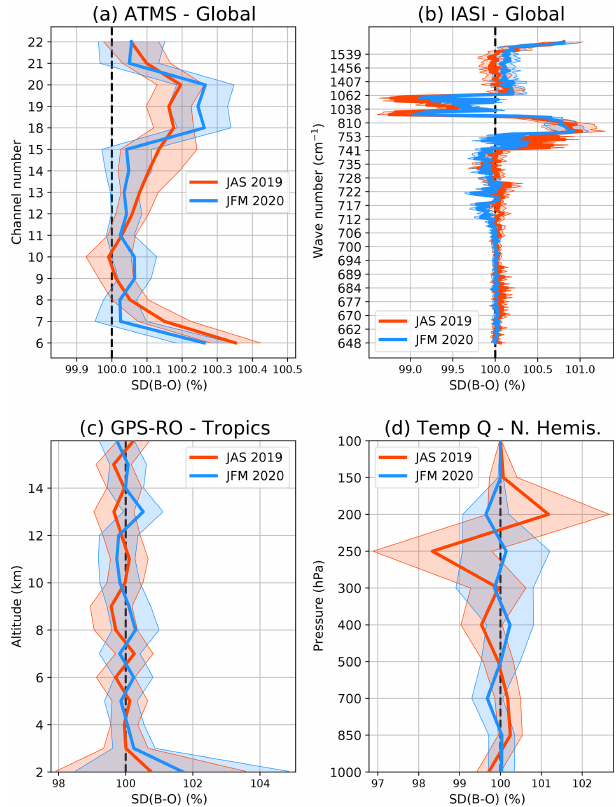
Figure 8. Normalised first-guess fit to observation in (%) for vari- ous observation types (see panel headings) for JAS 2019 (red) and JFM 2020 (blue). The shaded area represents the variability (1 stan- dard